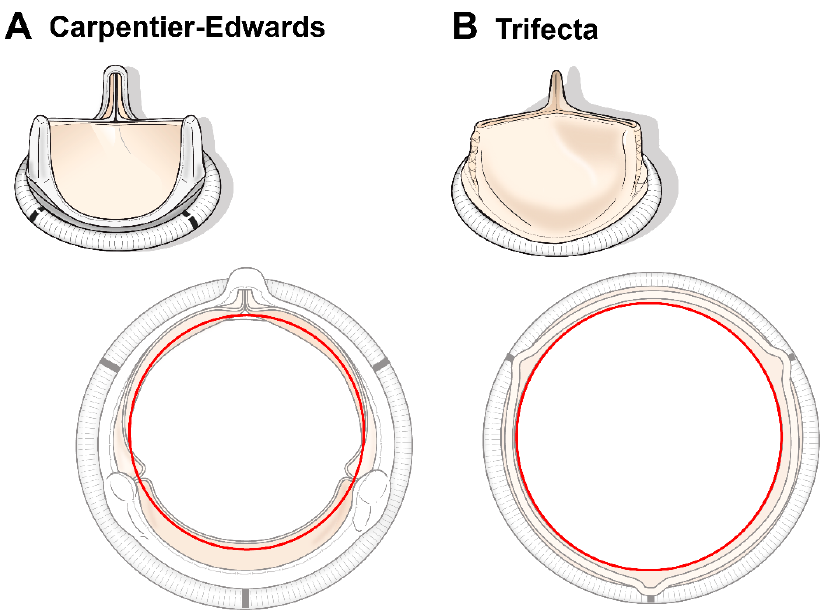
Figure 4. Two different valve designs: ( A ) Carpentier-Edwards (C-E) valve with internally mounted leaflets; ( B ) Trifecta valve with externally mounted leaflets. The Trifecta valves are associated with a larger effective orifice area than the C-E valves.